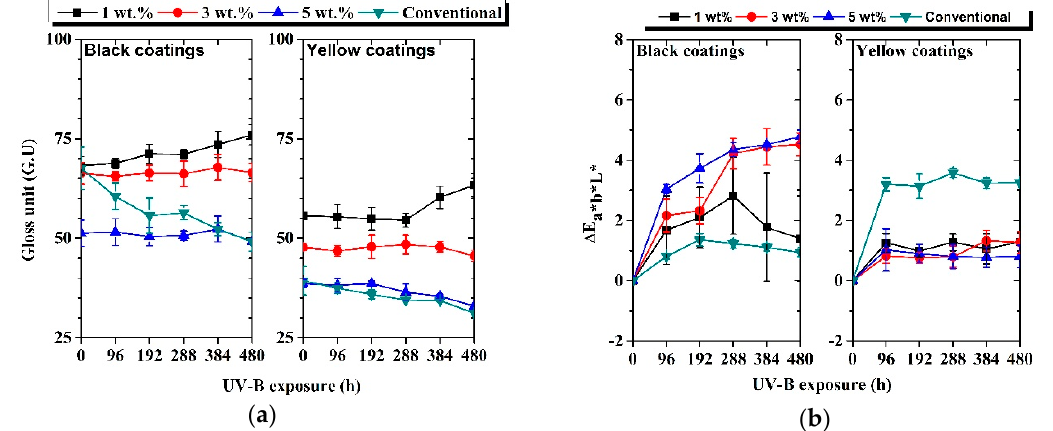
Figure 8. Evolution of 60° gloss units ( a ) and color variation, Δ E L * a * b * ( b ), as a function of UV-B exposure time.